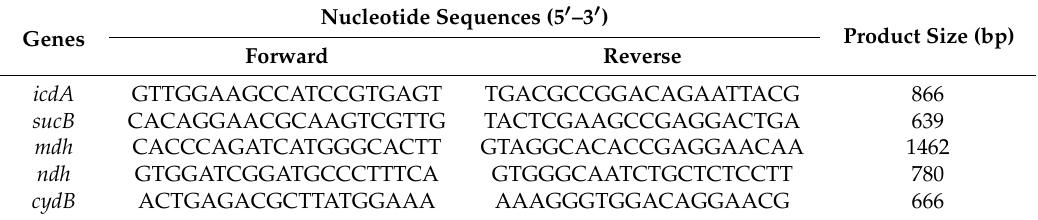
Table 2. Primers in PCR for P. polymyxa